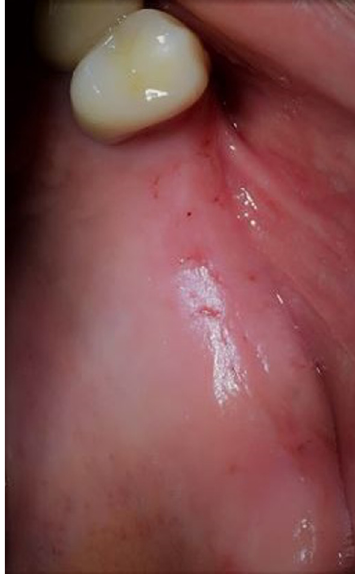
Fig. 4. Clinical picture 12 weeks